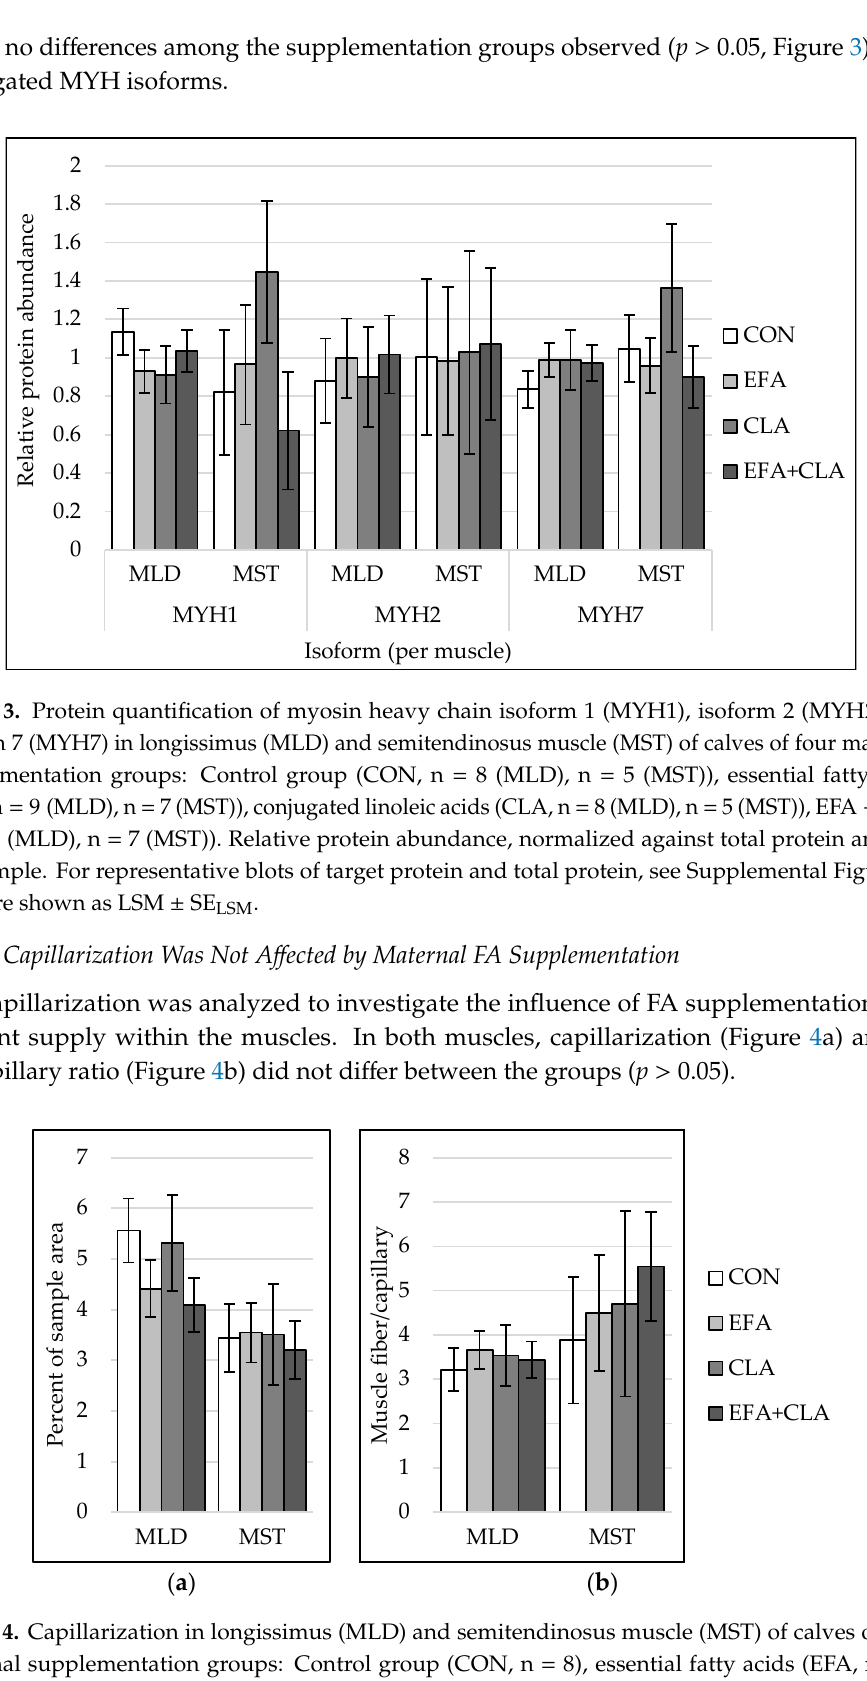
conjugated linoleic acids (CLA, n = 8), EFA + CLA (n = 11). ( a ) Percent of sample area. ( b ) Number of